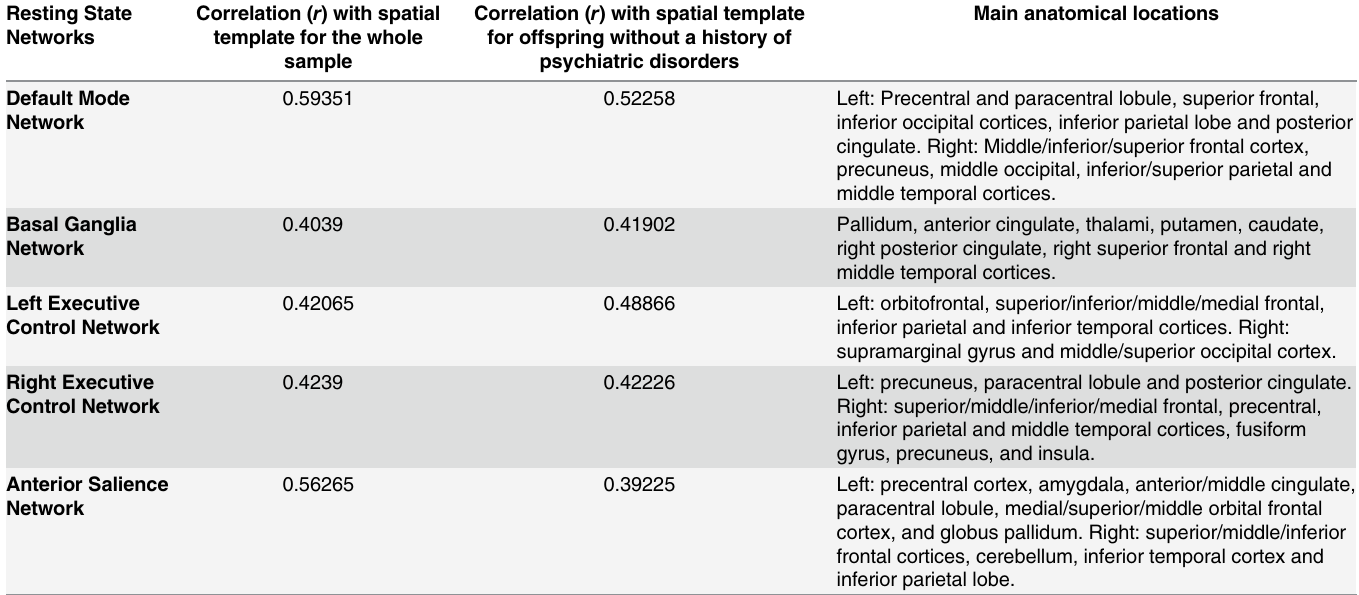
Table 3. Resting-state components.